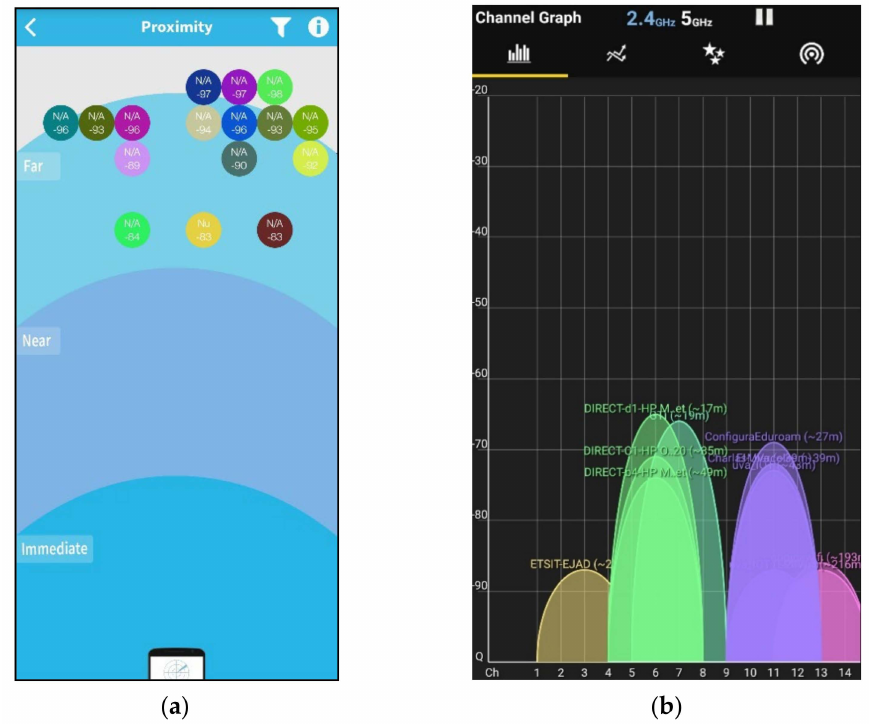
Figure 13. Proximity signals for starting location. ( a ) Bluetooth signals are concentrated far away